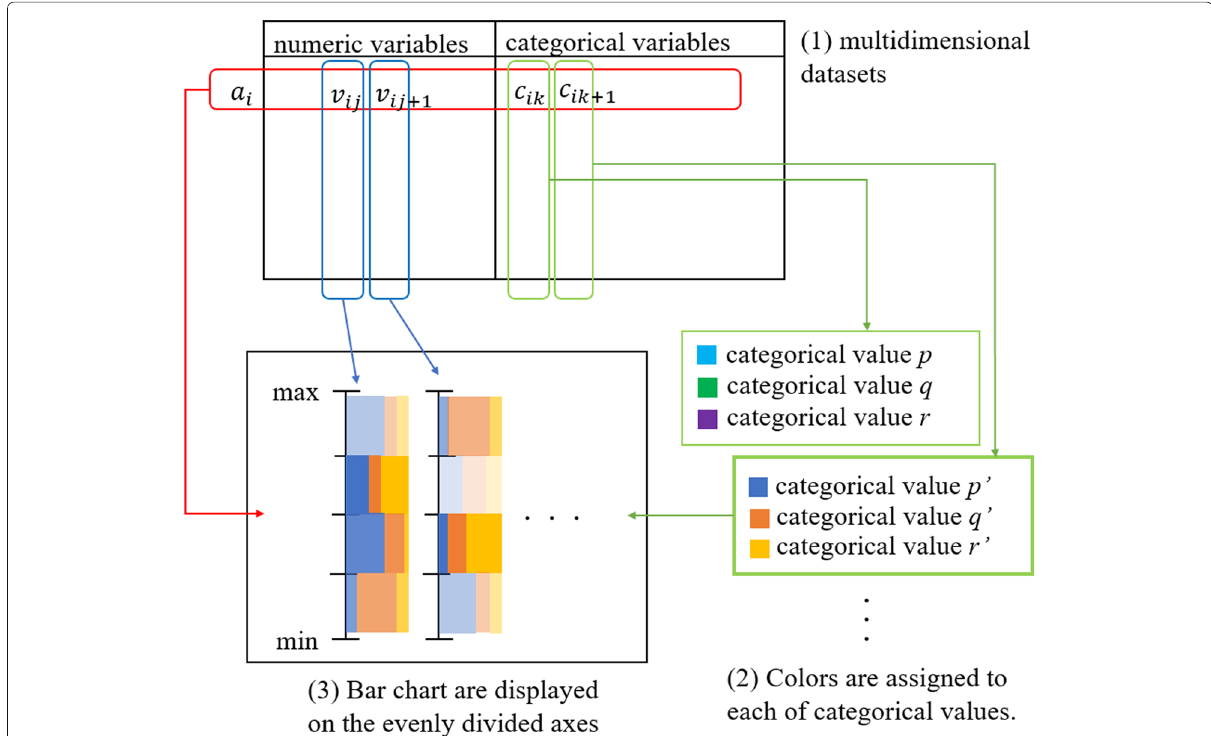
Fig. 1 Processing flow of the presented technique. 1 multidimensional datasets. 2 Colors are assigned to each of categorical values. 3 Bar chart are displayed on the evenly divided